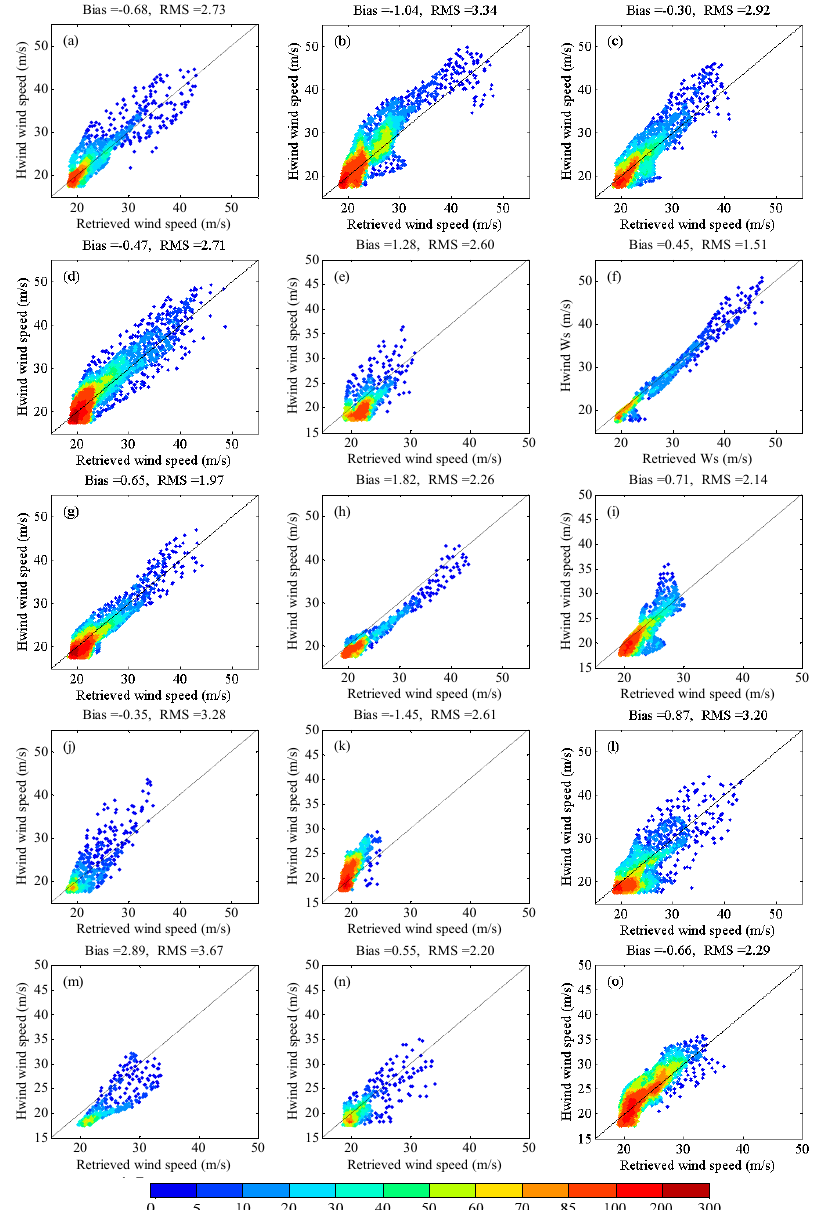
Figure 8. The comparisons between H*wind wind speed and the retrieved wind speed with our new model using WindSat 6 and 10 GHz brightness temperatures for each selected hurricane: ( a ) Fabian; ( b ) Isabel; ( c ) Frances; ( d ) Ivan; ( e ) Dennis; ( f ) Katrina; ( g ) Rita; ( h ) Wilma; ( i ) Helene; ( j ) Felix; ( k ) Bertha; ( l ) Ike; ( m ) Bill; ( n ) Ida; and ( o ) Igor.